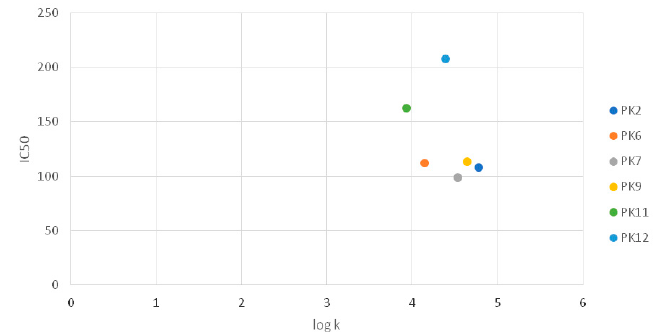
Figure 3. Graph comparing IC 50 values with logk.